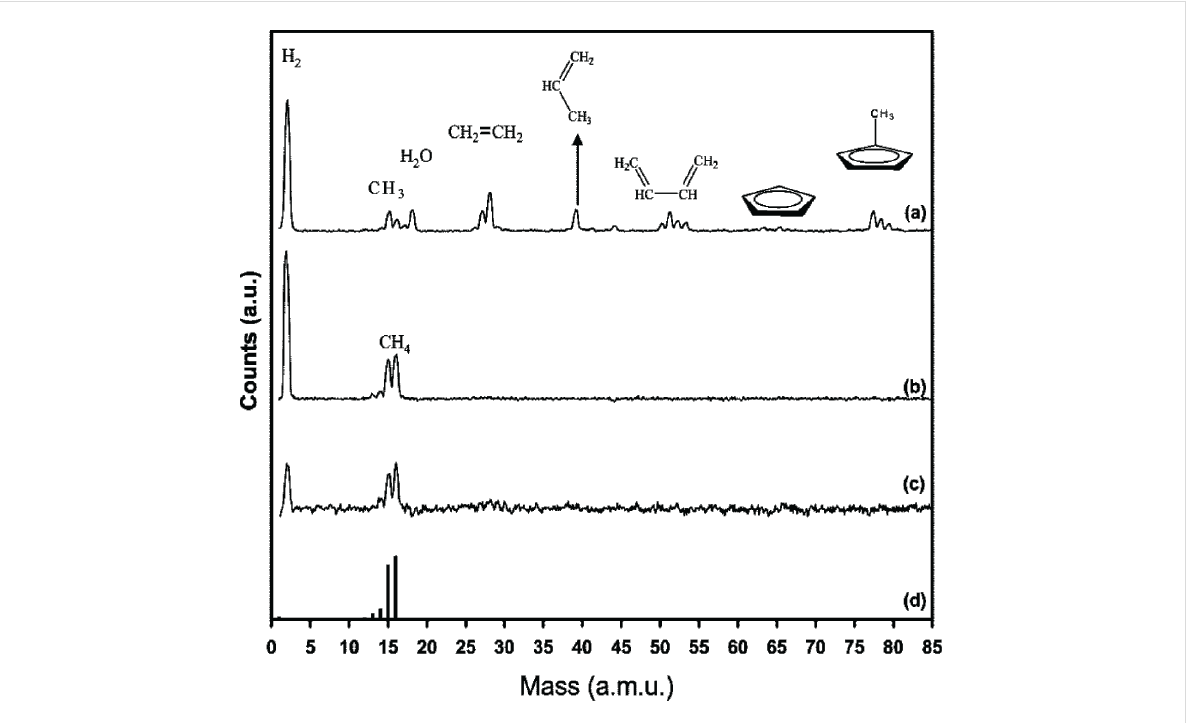
Figure 9: Positive ion mass spectra of MeCpPtMe 3 in the m / z range of 0–85 (reproduced with permission from Wnuk et al. [21], Copyright (2009) American Chemical Society): (a) gas phase spectrum recorded at 70 eV impact energy; (b) positive ion mass spectrum of volatile species desorbing from a MeCpPtMe 3 film, adsorbed onto a gold substrate at 180 K, under irradiation with 500 eV electrons; (c) positive ion mass spectrum of volatile species desorbing from a CpPtMe 3 film, adsorbed onto a gold substrate at 180 K, under irradiation with 500 eV electrons; (d) reference mass spectra of gas phase CH 4 (adapted from NIST